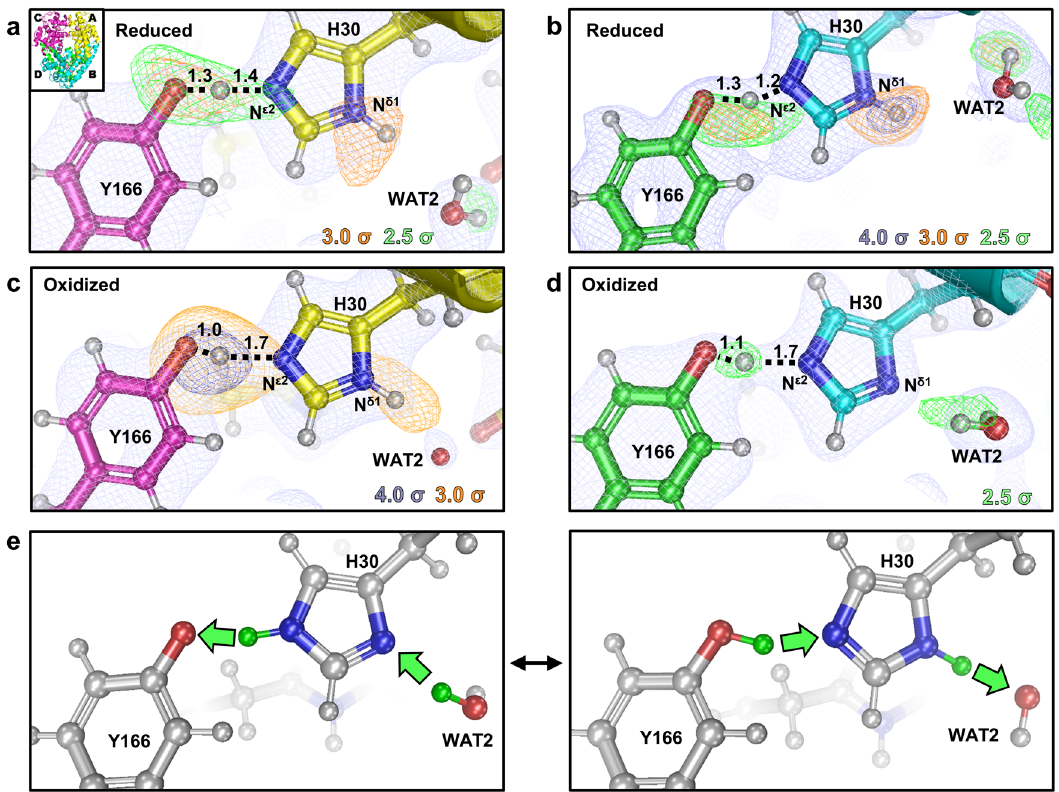
Fig. 5 Protonation states observed for His30 and Tyr166 among the different chains of Mn 2 + SOD and Mn 3 + SOD. a , b Neutron structures at the His30-Tyr166 interface of Mn 2 + SOD. c , d Neutron structures at the His30-Tyr166 interface of Mn 3 + SOD. The inset of a indicates chain identity. Light blue 2| F o | − | F c | neutron scattering length density is displayed at 1.0 σ . Purple-blue, orange, and green omit | F o | − | F c | difference densities are displayed at contours of 4.0 σ , 3.0 σ , and 2.5 σ , respectively. e Overall interpretation for a proton shuttle involving Tyr166 and His30. Numbers are distances in